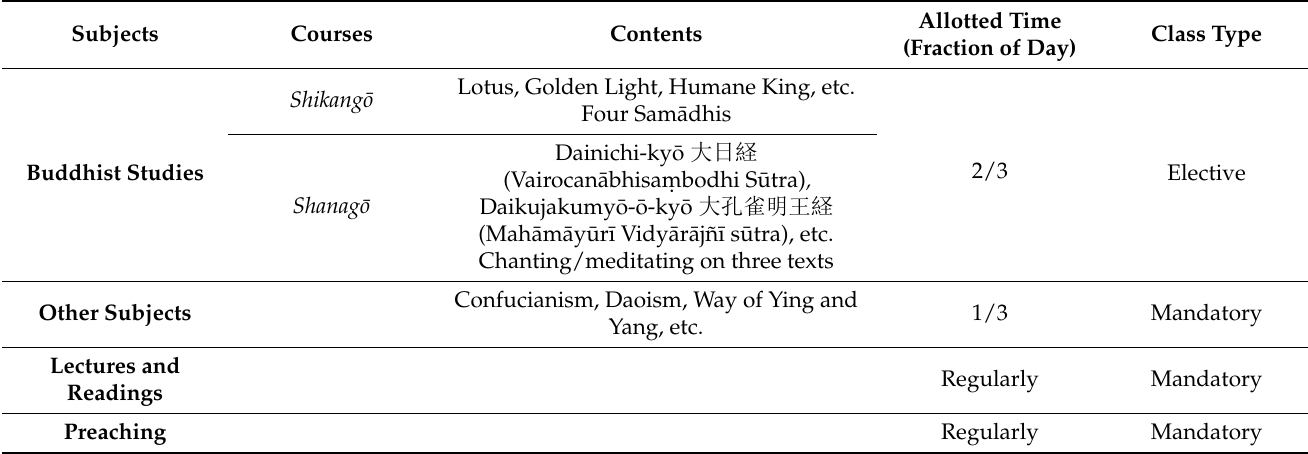
Table A1. Table summarizing contents of curriculum (translated from Yoshikawa 1970, p. 240).